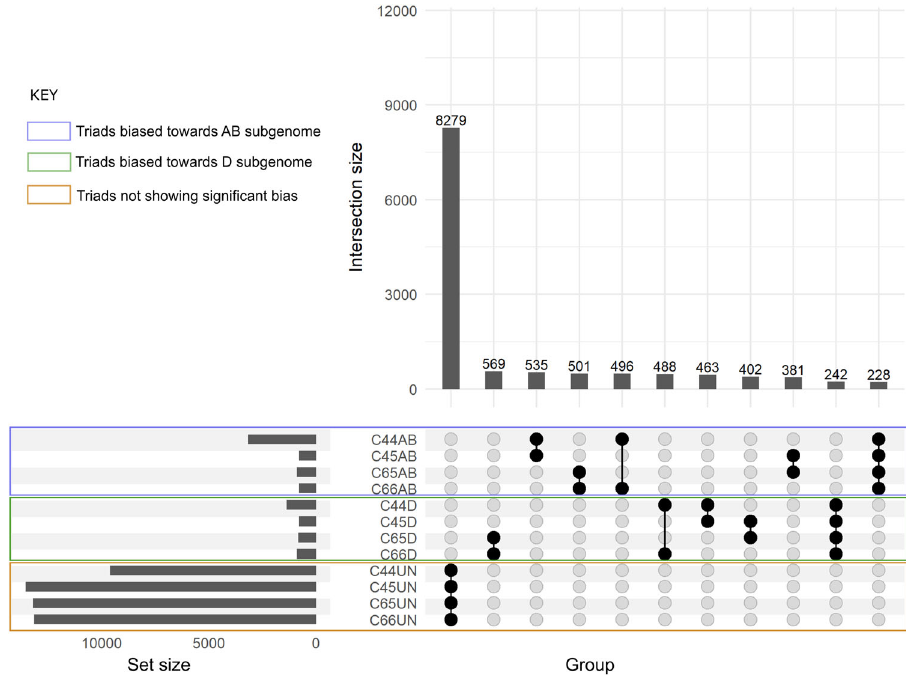
Fig. 5 Subsets of triads showing similar expression pattern across all four SHW lines in shoot tissue. The gray horizontal bars under set size corresponding to C44AB indicates the number of triads biased towards the AB subgenome in the SHW-C44; C44D indicates the number of triads biased towards the D subgenome in the SHW-C44; C44UN indicates the number of triads showing no signi fi cant bias in the SHW-C44; Similarly, for SHWs C45, C65 and C66. The vertical bars under intersection size indicate the number of triads showing similar expression patterns between sets. The black dots highlight the two SHW sets compared for the corresponding intersection. The number over the bars represents the number of triads showing similar expression pattern. The triad sets showing signi fi cant bias towards the AB or D subgenomes and those not showing any signi fi cant bias are highlighted by the blue, green and brown rectangles,